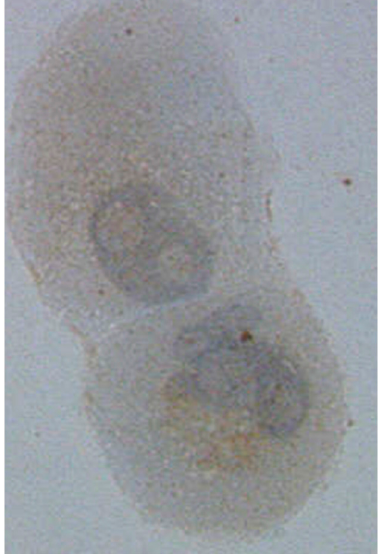
Figure 1. Anaplastic thyroid cancer cells cultured from surgical thyroidal samples stained with cytokeratin (magnification, 400×).